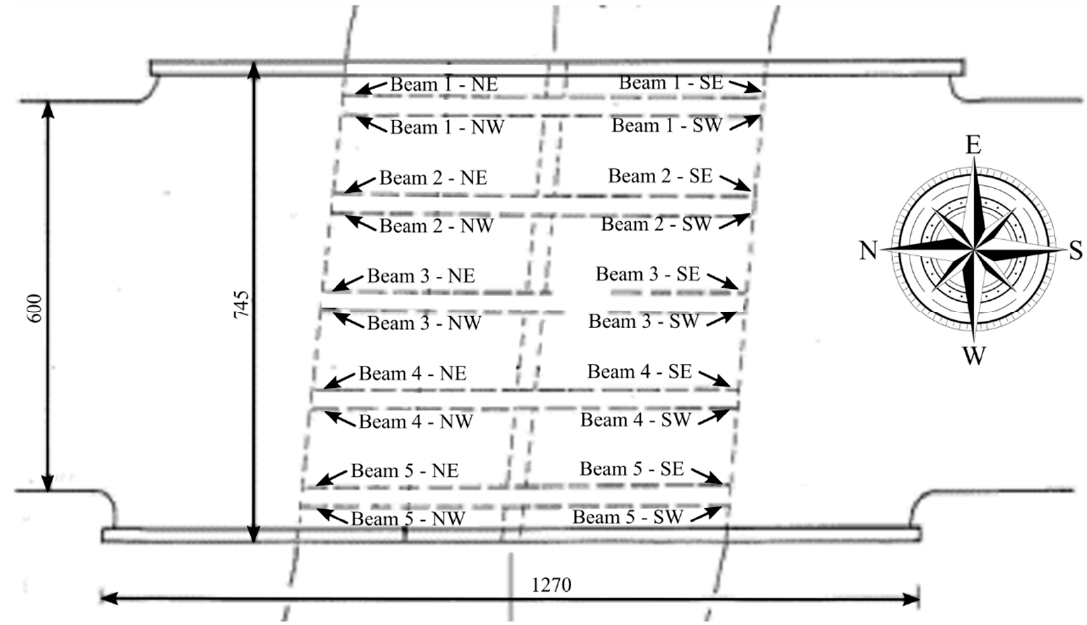
Figure 15. Beam numbering used for the pre-stressing procedure.